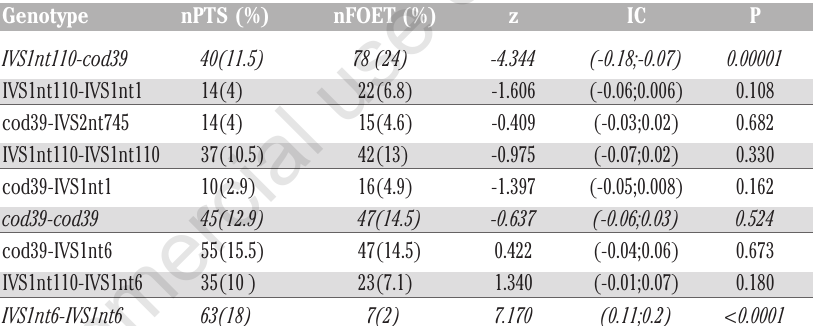
Table 1. Comparison between prevalence of patient genotypes and genotypes of β -tha- lassemia affected fetuses (1993-2006). Genotype